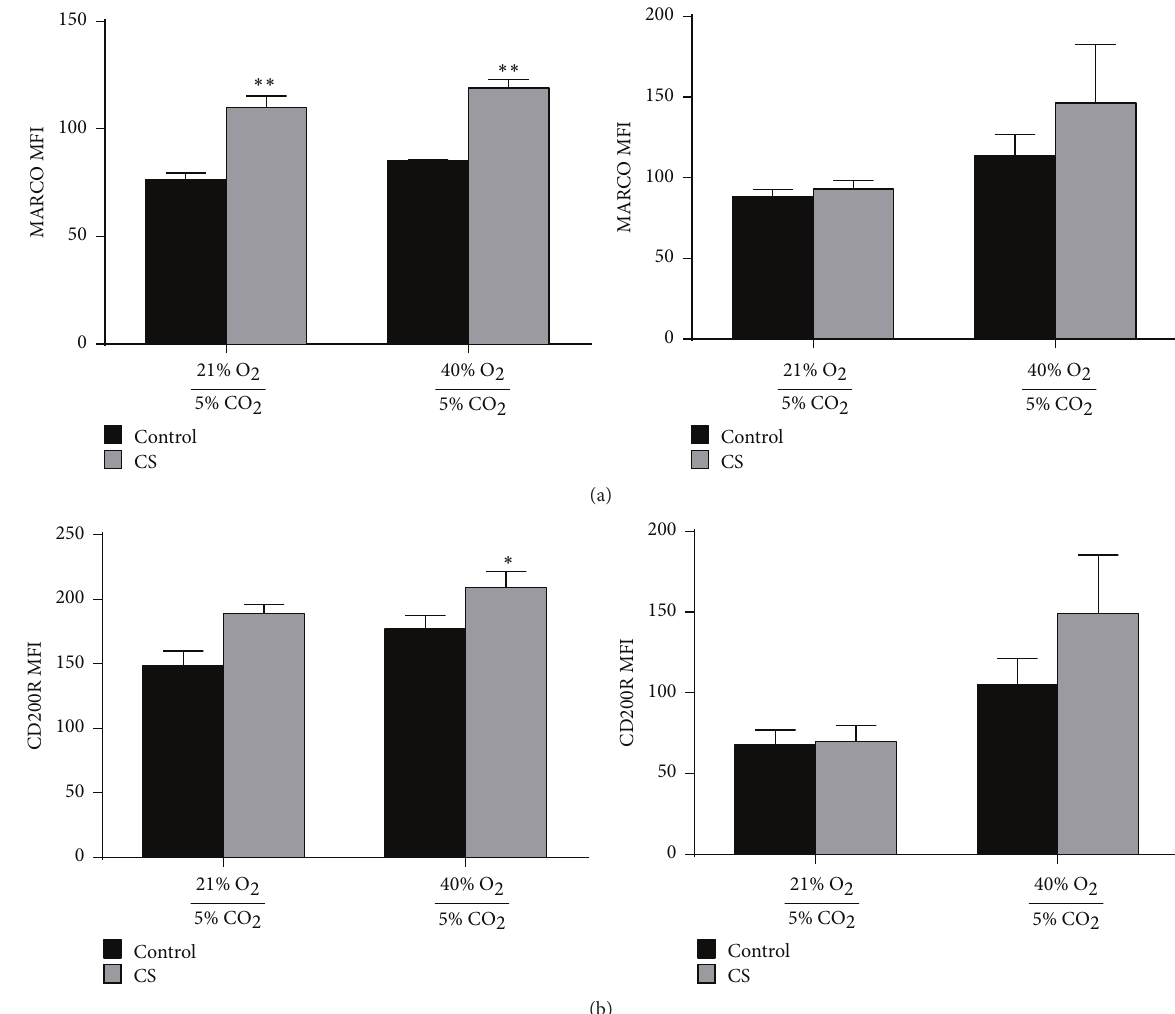
Figure 5: Oxygen regulates additional phagocytic receptors on CS-exposed macrophages. (a) We quantified MFI of MARCO expression on MH-S macrophages following CS and oxygen exposure prior to (left) and after (right) incubation with PAO1 bacteria (mean ± SEM, 𝑛 = 3 , ∗∗ 𝑝 < 0.01 compared to both control + 21% O 2 and control + 40% O 2 groups by one-way ANOVA with Bonferroni correction). (b) We also quantified CD200R expression by MFI on MH-S macrophages prior to (left) and after (right) incubation with PAO1 bacteria (mean ± SEM, 𝑛 = 3 , ∗ 𝑝 < 0.05 compared to control + 21% O 2 group by one-way ANOVA with Bonferroni